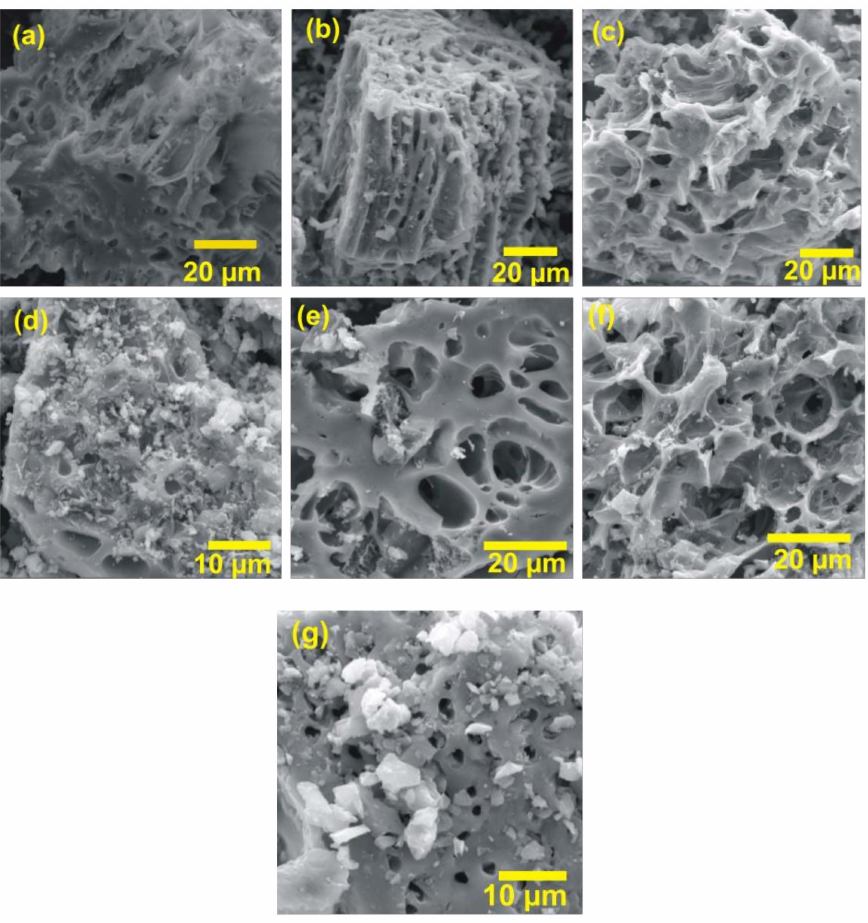
Figure 3. SEM images of ( a ) untreated, ( b ) AC-400 ◦ C, ( c ) AC-500 ◦ C, ( d ) AC-600 ◦ C, ( e ) AC-700 ◦ C, ( f ) AC-800 ◦ C, and ( g ) NAC-700 ◦